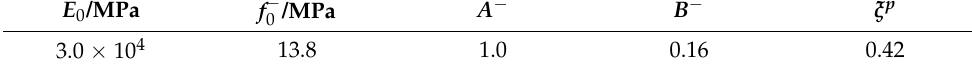
Table 5. Simulation parameters of cyclic compression test.